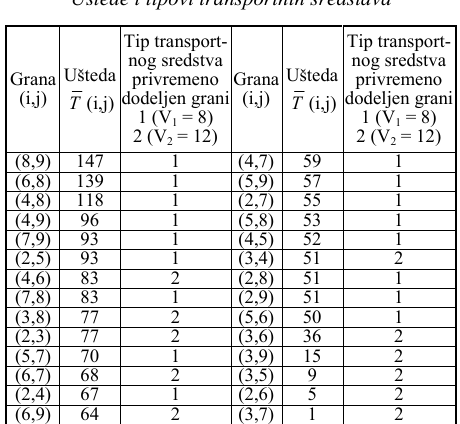
U{tede i tipovi transportnih sredstava